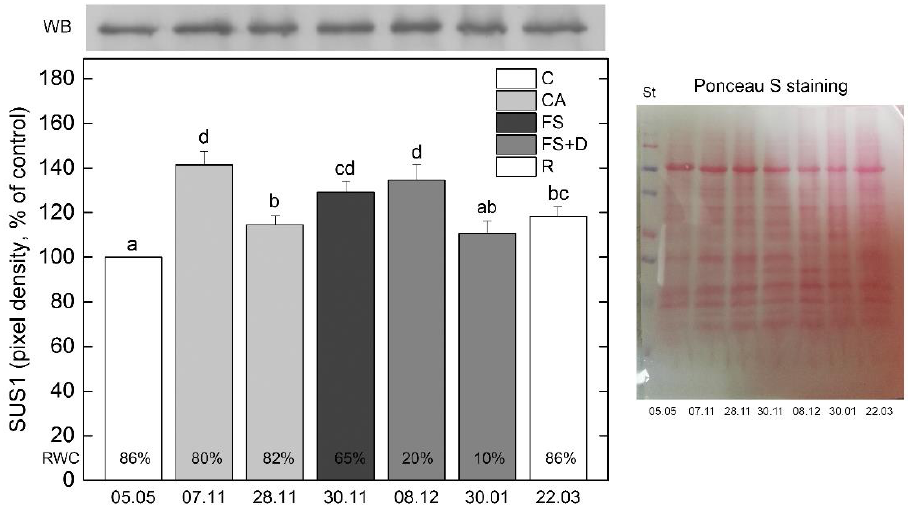
Figure 7. Changes in the expression of Sucrose synthase 1 (SUS1) protein in leaves of Haberlea rhodopensis after exposure to low temperatures during cold acclimation (CA, period: 7–28 November) freezing stress (FS, − 10 ◦ C, 30 November), freezing-induced desiccation (FS + D, period: 8 December–30 January) and after recovery of plants in early spring (R; period: 22 March) under natural ex situ environmental conditions. A representative Western blot is presented in the graph. 30 µ g protein was applied per lane. Percentages at the bottom of the columns show the relative water content (RWC) of plants at each sampling point. The same letters within a graph indicate no significant differences assessed by Fisher’s LSD test ( p ≤ 0.05) after performing ANOVA. Ponceau S staining of the membrane after blotting is presented on the right. SUS1 values are normalized according to Ponceau S staining. St: Precision Plus Dual Color Protein™ Prestained Standards (Bio-Rad, Hercules, CA,